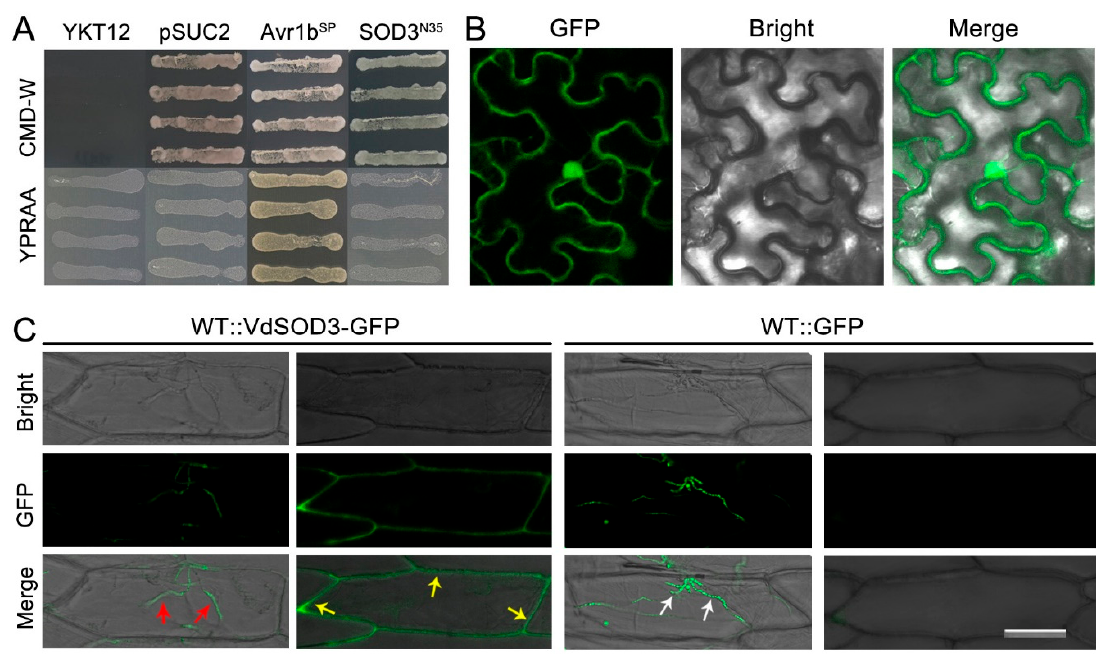
Figure 2. Signal-peptide-lacking VdSOD3 can be secreted. ( A ) Validation of the nonsecretion function of the 35-aa N - terminal peptide of VdSOD3 using the yeast signal trap assay. The known functional signal peptide Avr1b was used as a positive control. ( B ) Subcellular localization of VdSOD3 was determined by transient expression of VdSOD3-green fluorescent protein (GFP) in N. benthamiana leaves. ( C ) VdSOD3 can be secreted extracellularly during infection. V. dahliae strain wild-type (WT)::VdSOD3-GFP was used to infect onion epidermal cells, and confocal microscopic images were taken at 2 days postinoculation. WT::GFP inoculated onion cells were used as a negative control. The red arrow indicates green fluorescence of VdSOD3-GFP observed in the fungal hyphae of WT::VdSOD3-GFP, while the white arrow indicates green fluorescence of free cytosolic GFP observed in the fungal hyphae of WT::GFP. The yellow arrow indicates green fluorescence of secretory VdSOD3-GFP around onion epidermal cells.Bar, 50 μ m.